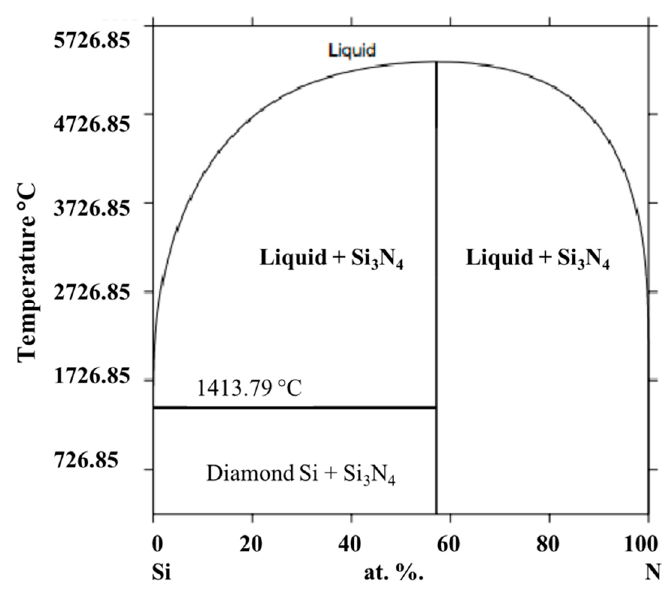
Figure 1. Calculated phase diagram of Si-N system based on [25].